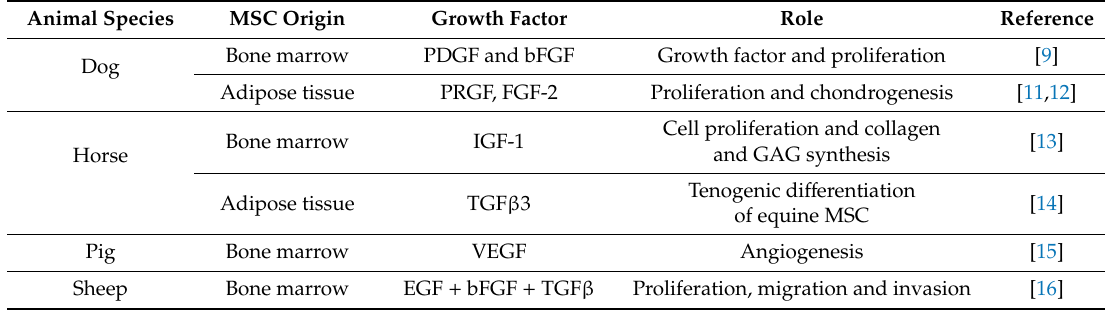
Table 1. Growth factors and their influence on biological activities of MSC from animal species. Animal